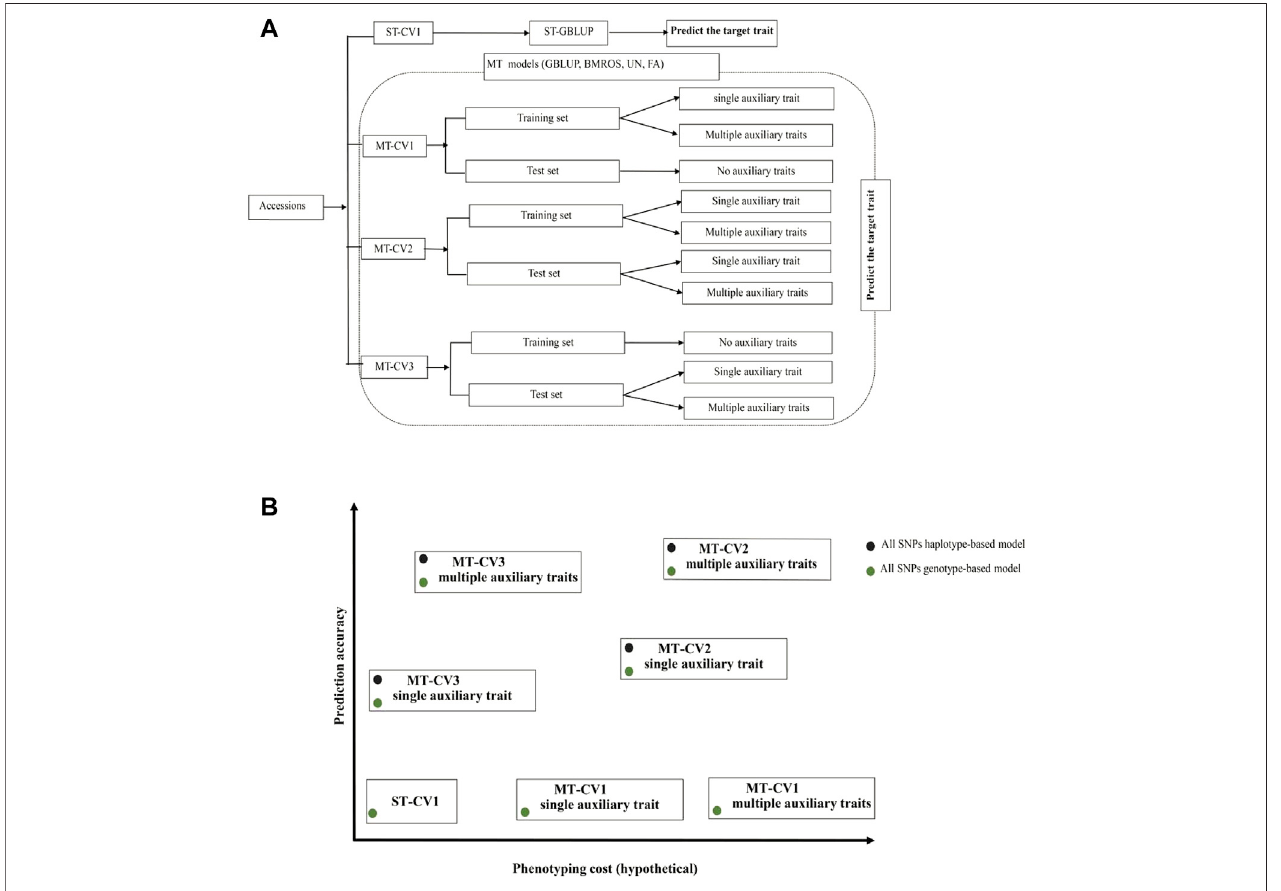
FIGURE8 | General recommendations for using cross-validation (CV) schemes and multi-trait(MT) models. (A) Anillustration ofthe different CV partitions and trait combination scenarios evaluated. (B) Expected prediction accuracy and phenotyping cost for different CV schemes and MT models. Green dots represent models which account only for additive effects. Black dots represent models considering both additive and local epistatic effects. The GBLUP model under ST-CV1 is economically advantageous becausethemain effortisjustdevoted tophenotypingone targettraitinthetrainingset.However,interms ofprediction accuracy, itis less robust than the UN and FA MT models under MT-CV2 or MT-CV3. Compared to ST-GBLUP, using MT models under MT-CV1 has no advantage in phenotypic